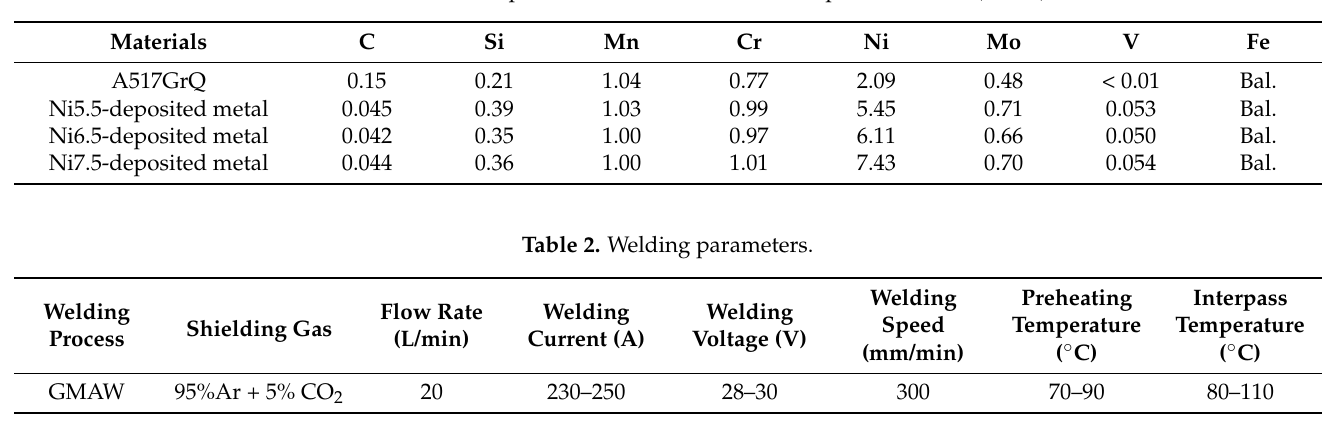
Figure 1. ( a ) is the schematic diagram of the welding joint, and ( b ) is the sampling position of the mechanical samples. The number of 1–12 in ( b ) represents the welding sequence. Table 1. Chemical composition of A517GrQ and the deposited metals (wt. %).